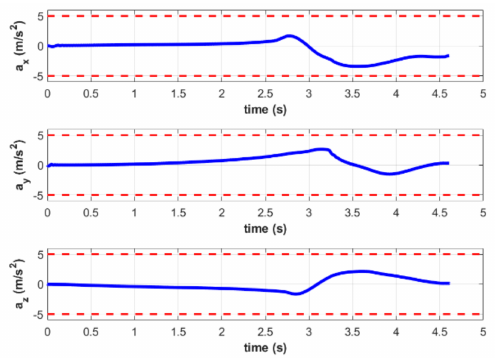
Figure 16. Acceleration of the quadrotor in simulation